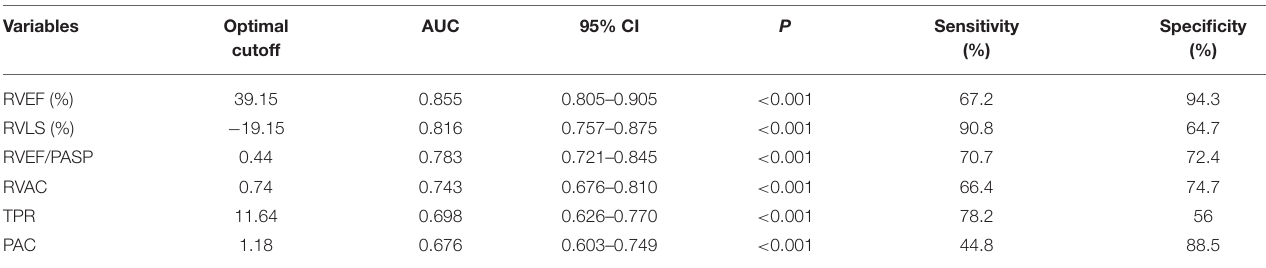
TABLE 5 | ROC curve analysis determining the optimal cutoff values of tested